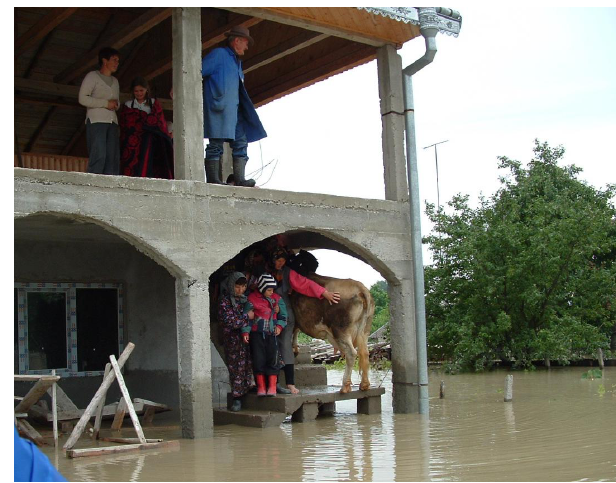
Fig. 5. Inhabitants saving a cow in Vadu Ros¸ca during the flood of July 2005 (Picture: Administrat¸ia Nat¸ional˘a “Apele Figure 5. Inhabitants saving a cow in Vadu Roşca during the flood of July 2005 (Picture: 3 Administraţia Naţională « Apele Române ») 4